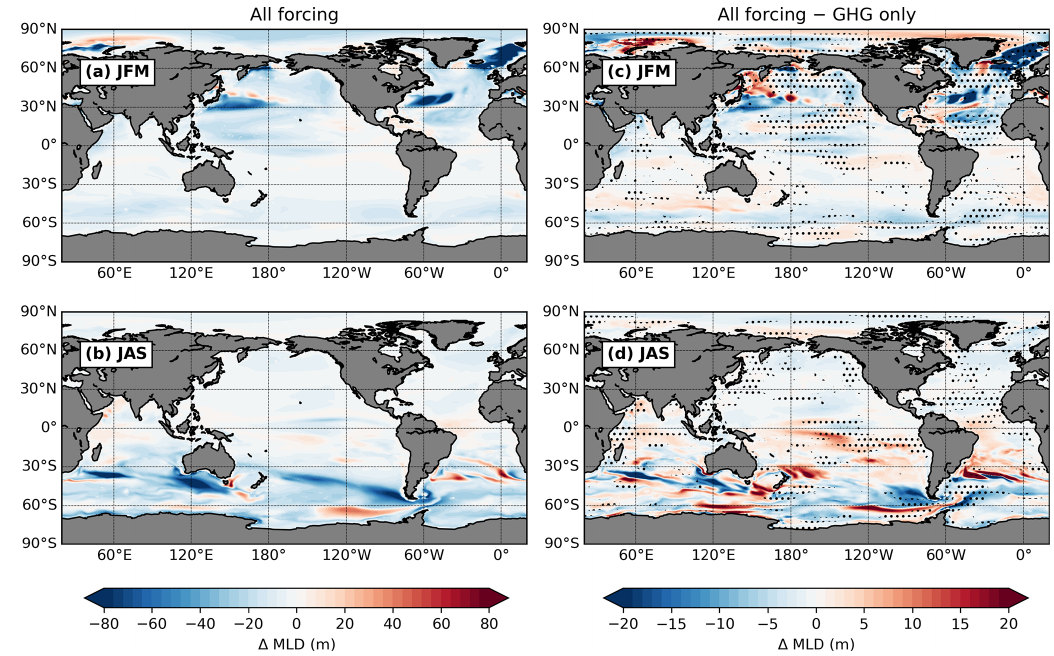
Figure 11. Same as Fig. 9 but for the MLD (m) based on a critical density threshold of 0.03kgm − 3 .